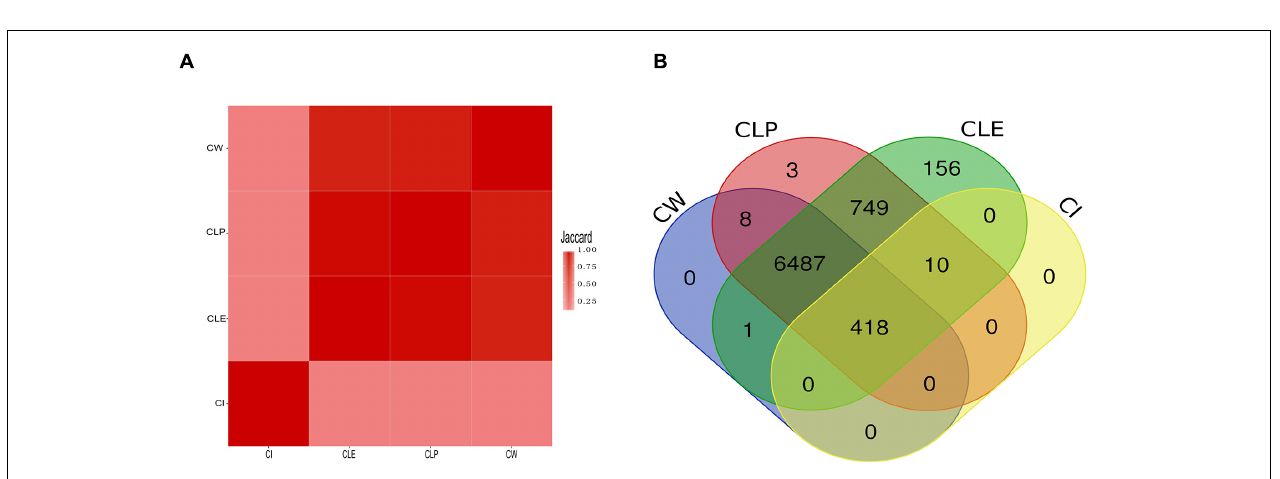
FIGURE 2 | Distribution of cluster size and the overlap of the big clusters among the four algorithms. (A) The distribution of cluster size identified by CW, CLP, CLE, and CI algorithms in MCF-7 cell PPI network. The y -axis shows the number of clusters, and the x -axis gives two groups across four methods, which is classified based on the threshold of member number in each cluster. (B) Distribution of cluster size. The size of clusters detected by four different community partition methods (CLE, CLP, CW, and CI) in the MCF-7 cell PPI network. The x -axis represents the size of the cluster, and the y -axis describes the density of clusters.